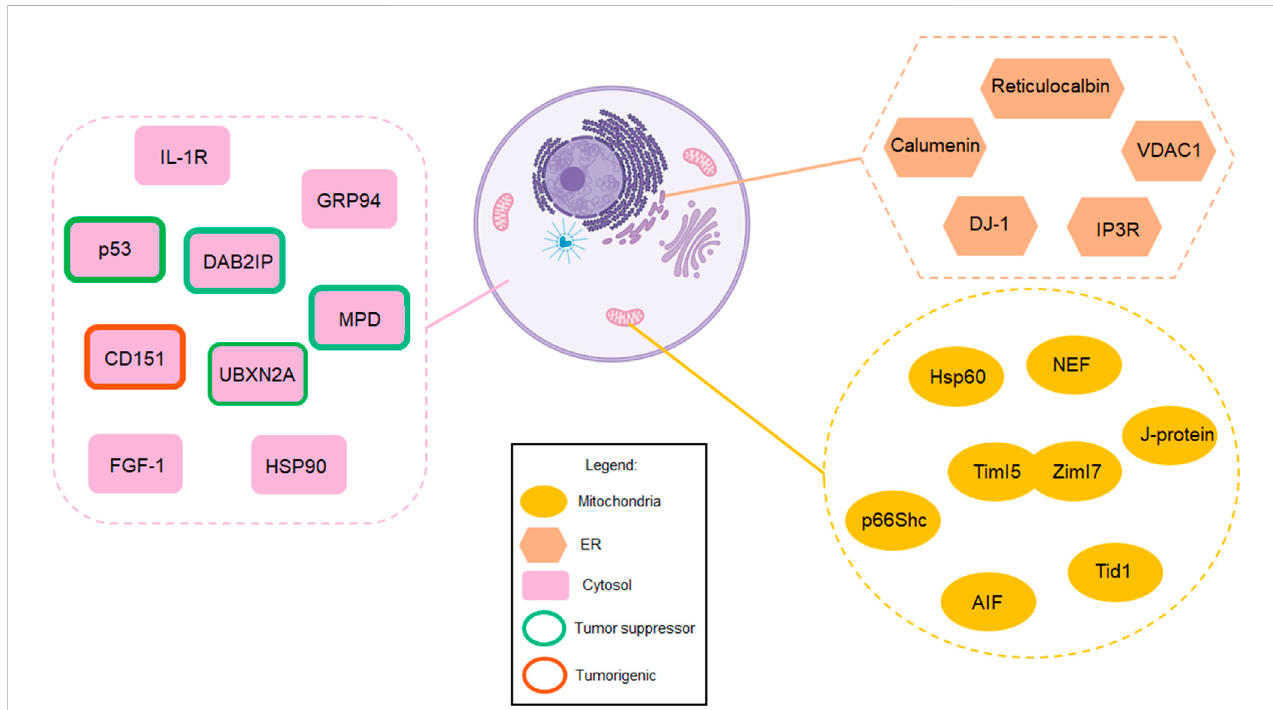
Mortalin acts as a “ double agent, ” playing contrasting roles in normal cells versus cancer cells. This fi gure summarizes mortalin ’ s partners in different subcellularcompartments, includingmitochondria, thecytosol, andthe endoplasmic reticulum (created withBioRender.com).While mortalin ’ s functions are essentialfornormalcells,itsinteractionpartnersallowmortalintobecomeapoorprognosticfactorinhumancancer.Understandingthesetwodifferentfaces ofmortalinwill enablethedesign of anti-mortalin drugs that regulateits tumorigenicpathways in cancer cells while its physiologicalfunctionsin normal cells remain intact. These partners have different binding af fi nities to mortalin, and their interactions are conditional on the cellular context. Therefore, future studies will determine the biological and pathological impact of these interactions in a tissue-dependent